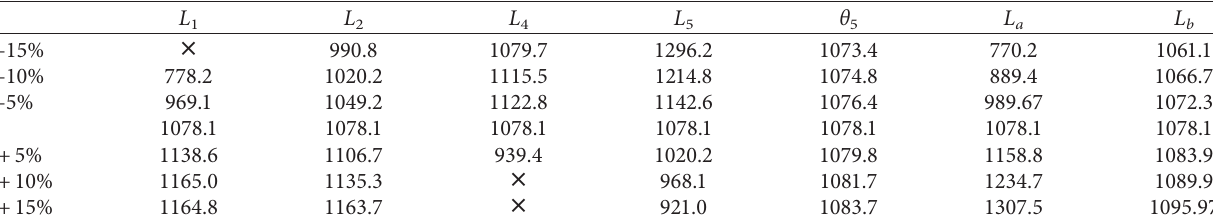
Table 4: Torque value T /Nm with variable parameters.